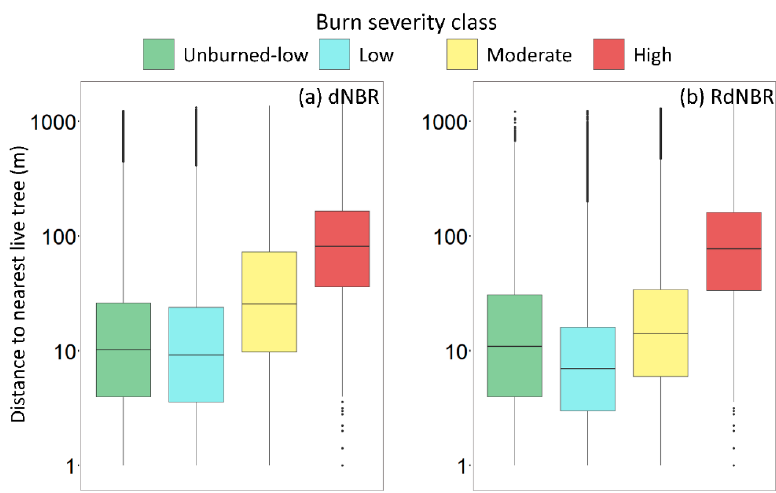
Figure 5. Distances to nearest live tree within open areas, as inferred by Euclidean distance to nearest fire refugia patch edge, partitioned by ( a ) dNBR- and ( b ) RdNBR-based burn severity classes. Note: fire refugia patch edge, partitioned by a ) dNBR- and b ) RdNBR-based burn severity classes. Note: y- y-axis is axis is log-scaled.